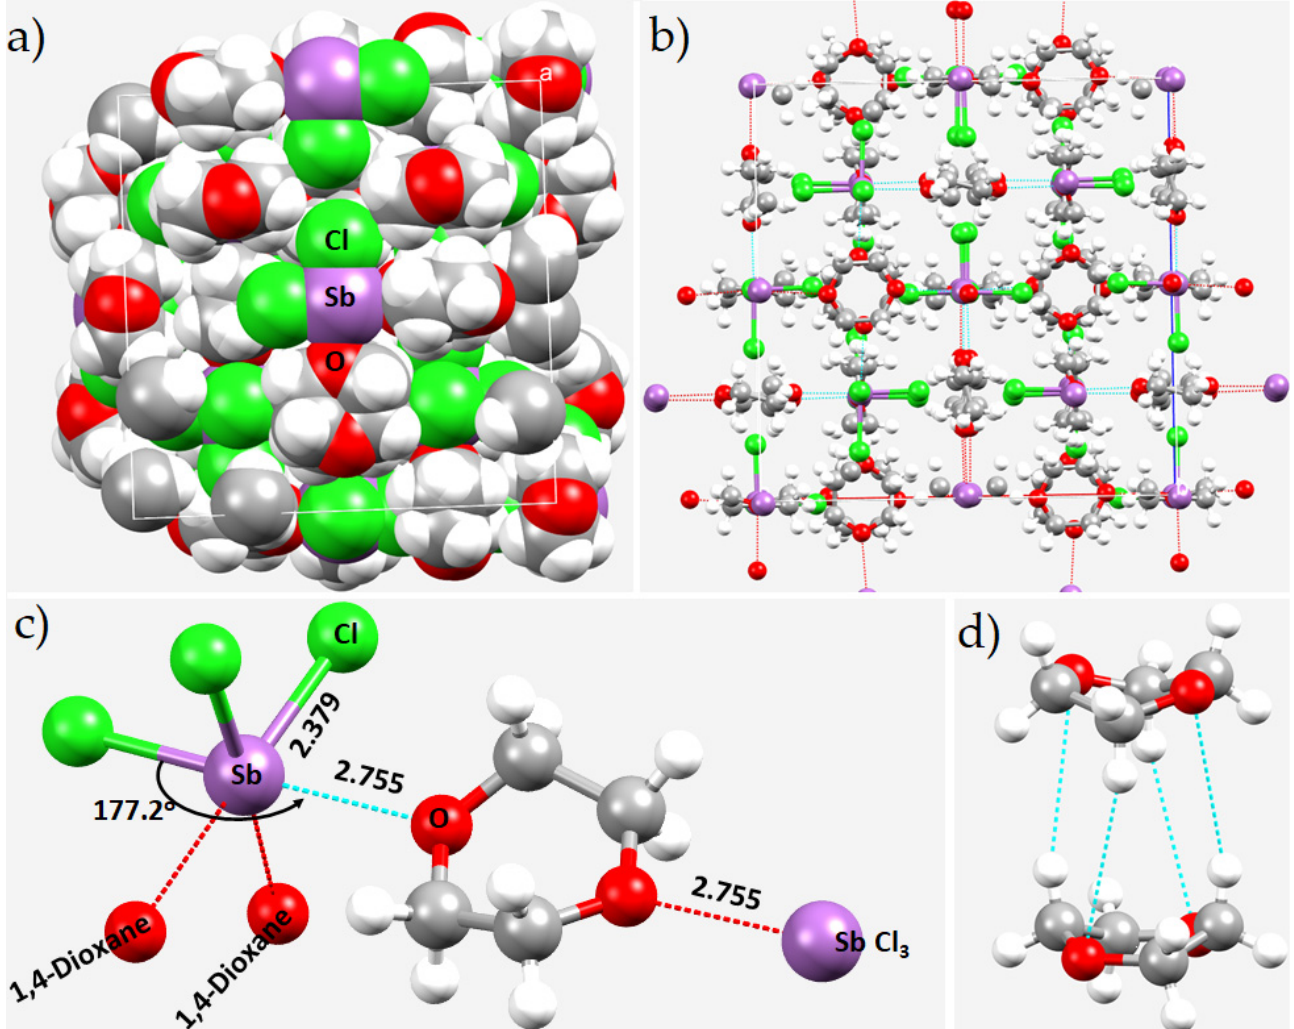
Figure 15. ( a ) The space-filling and ( b ) ball-and-stick models of the coordination of SbCl 3 with 1,4- dioxane as observed in the crystal of catena-(tris( μ 2 -1,4-dioxane-O,O’)-bis(trichloro-antimony(III)), CSD ref. code BEKHUV01). ( c ) Illustration of local Sb···O links in the crystal. ( d ) Hydrogen bonding topologies between 1,4-dioxane moieties in the crystal. Selected bond lengths and bond angles are in Å and degree, respectively. Hanging contacts are shown as dotted lines in red. Atoms are shown as small spheres and bonds as lines in atom color, whereas the intermolecular interactions are represented by dotted lines in cyan.